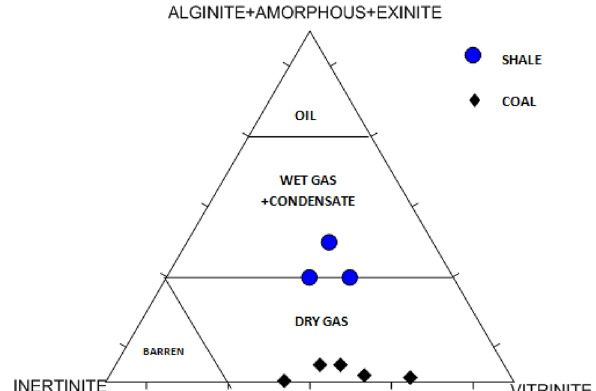
Fig. 21 Ternary plot indicating the proportion of the vitrinite, inerti- nite and liptinite and the corresponding hydrocarbon compared with the reference diagram of Tissot and Welte (1984). Plot indicates that the coal and shales are gas